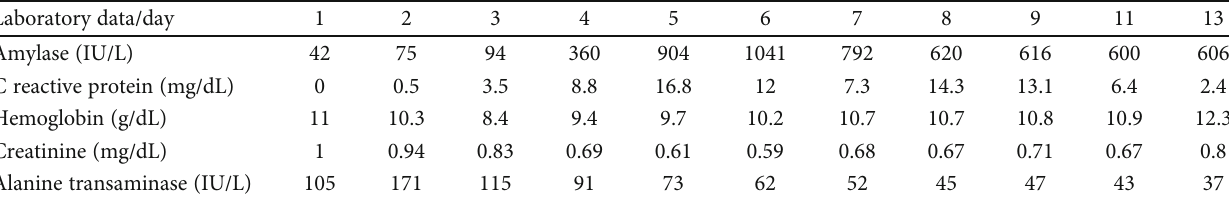
Table 2: Time course of level of main blood biochemical